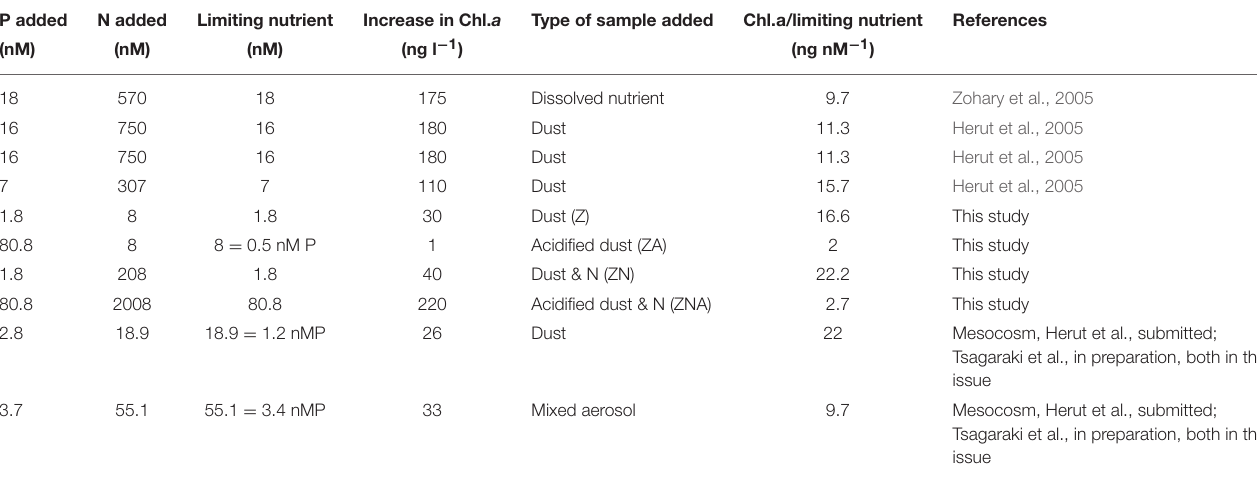
TABLE 4 | Table showing the ratio of Chlorophyll-a increase relative to the controls/concentration of the limiting nutrient added for a series of micro- and mesocosm-experiments carried out in the EMS during May. P